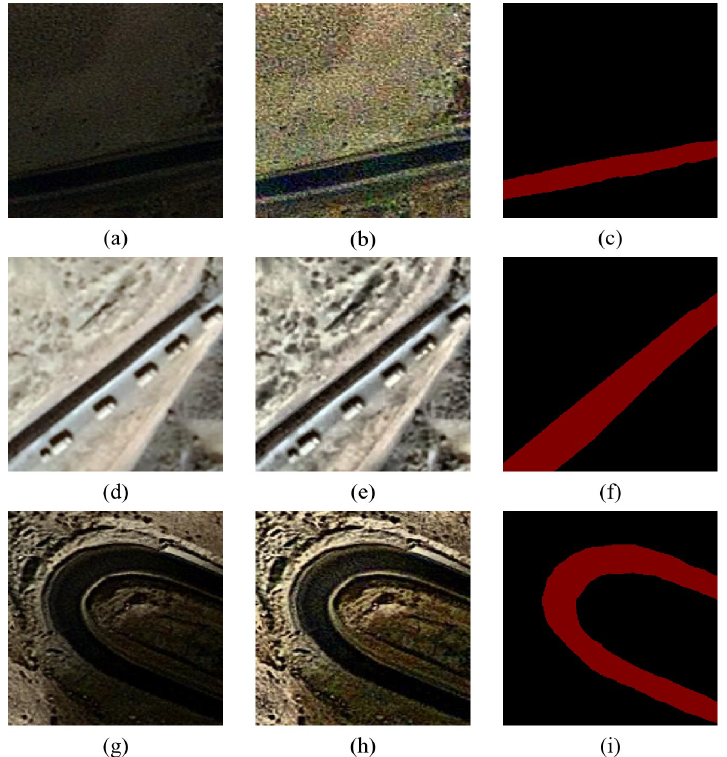
Figure 4. ( a , d , g ) is the original unprocessed image; ( b , e , h ) are the images after enhancement; ( c , f , i ) are the labels of